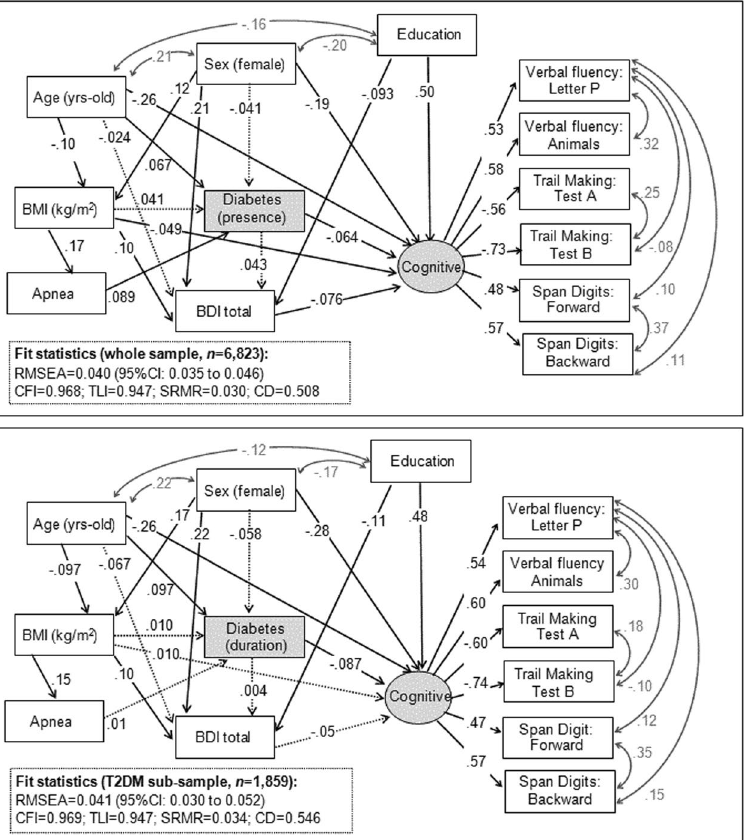
Figure 1. SEM model for the presence of type 2 diabetes (first panel) and for the duration of type 2 diabetes (second panel). Note. Continuous line refers to significant coefficients ( < 0.05 level). Dash-line refers to non- significant coefficients. Grey font: covariance